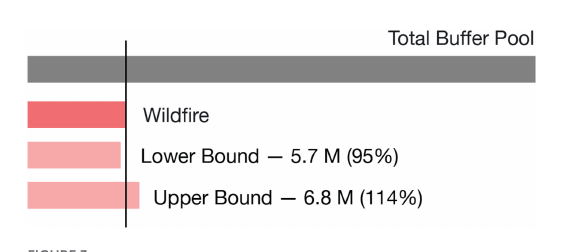
FIGURE3 Carbon losses from wildfire. Estimated carbon losses from historical wildfires are large enough to deplete the entire buffer pool contribution set aside for all wildfire impacts over 100 years. We combine verified reversals reported by two projects with our estimates of carbon loss for four projects affected by wildfire. The lower bound scenario makes maximally conservative assumptions for wildfire mortality, post-fire salvage logging, and accounting treatment of standing dead carbon. The upper bound scenario relaxes the conservative assumptions for these variables.